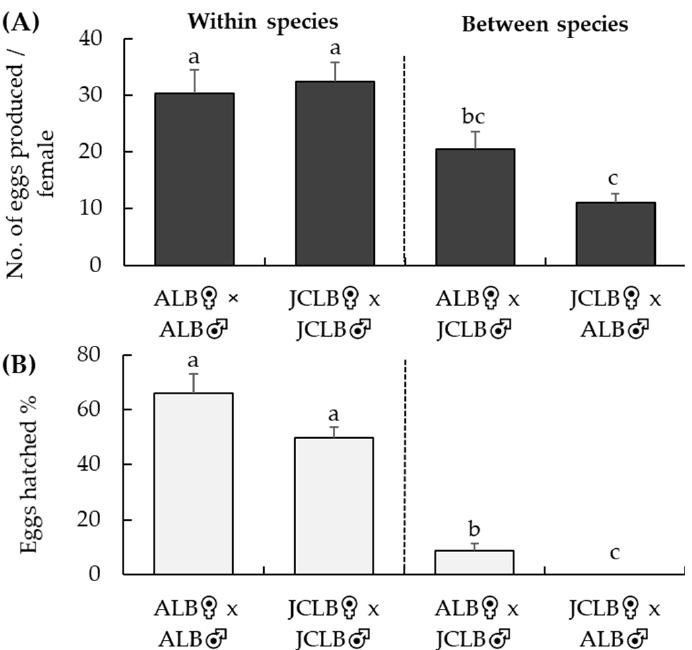
Figure 1. Crossing tests at BIIRU: numbers of eggs laid per female ( A ) Anoplophora glabripennis (ALB) and A. malasiaca (JCLB) over a 4-week period when paired with a conspecific or interspecific male and percentage of eggs hatched ( B ) in various crossing treatments. Bars refer to mean + SE and different letters above the bars indicate significant difference (ANOVA, p < 0.05).